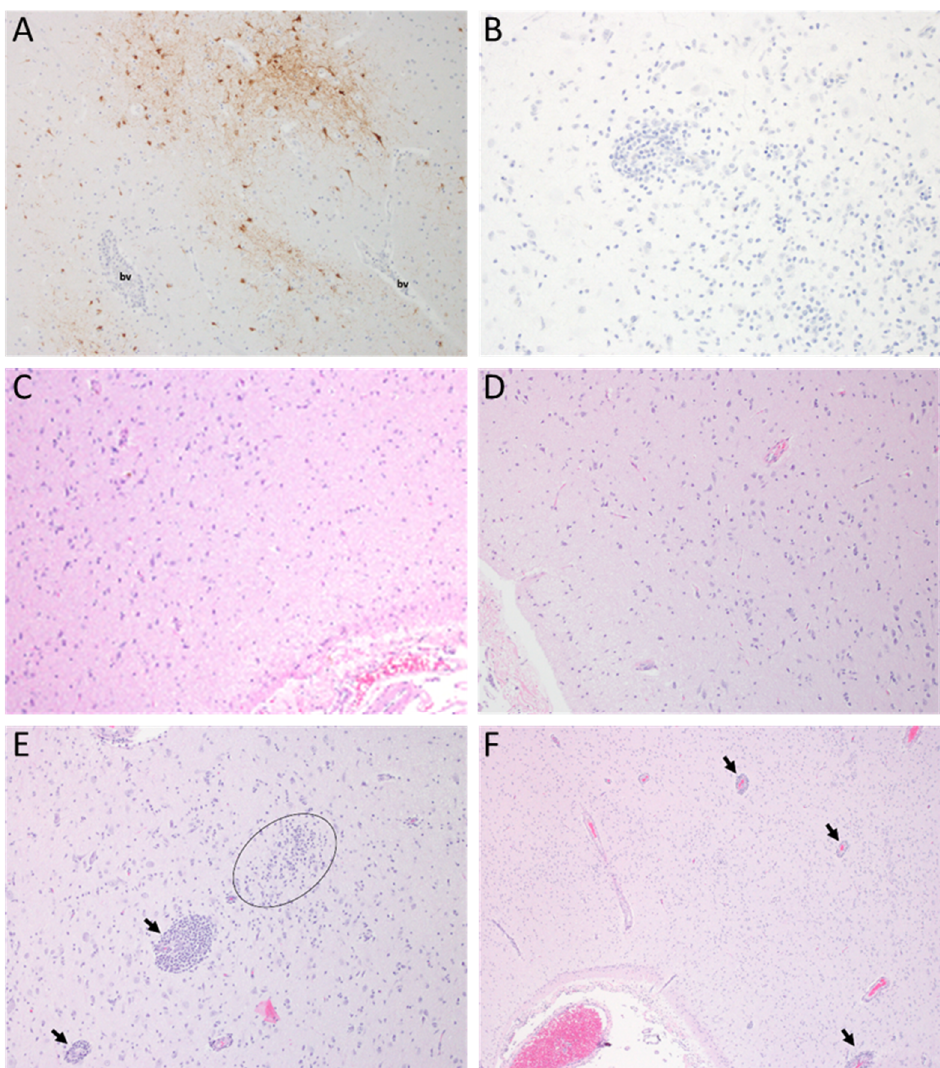
Figure 8. Pathological changes in NHPs following WEEV CBA87 exposure. Tissues were collected at time of euthanasia for immunohistochemistry ( A , B ) and hematoxylin and eosin examination ( C – F ). All images are of the cerebrum (corpus striatum) region. ( A ) ID CTRL-1 on day 8 post-exposure (PE), positive for WEEV antigen (10 × ); ( B ) ID CTRL-3 on day 29 PE, no WEEV positive staining (20 × ); ( C ) Normal healthy tissue (10 × ); ( D ) ID VRP-6 on day 28 PE (10 × ); ( E ) IM CTRL-1, perivascular infiltrate (arrows) and gliosis (circle) were observed on day 32 (4 × ); and ( F ) ID CTRL-1, perivascular infiltrates of lymphocytes and histiocytes (arrows) and multifocal gliosis within the neuropil on day 8 (4 × ). bv indicates a blood